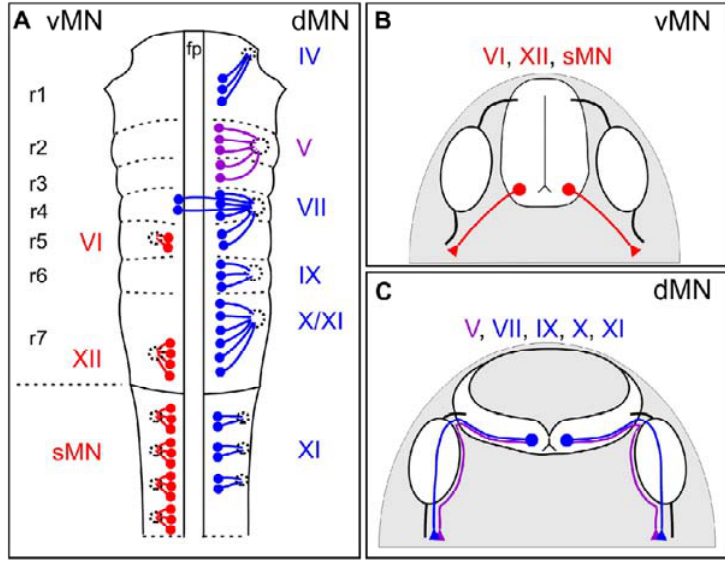
Figure 1. Motor neuron subtypes and the projections of their axons out of the CNS. ( A ) Schematic of motor neuron nuclei in the developing brainstem (rhombomere (r), r1 to r7) and spinal cord. vMNs are indicated in red on the left, whereas dMNs are indicated in blue on the right of the schematic. Trigeminal (V) motor nuclei are shown in purple. Each cranial motor nuclei is numbered in roman numerals, e.g., CN XI. Abbreviations: fp, floor plate; sMN, spinal motor neuron; ( B ) Axonal projections of vMNs in the hindbrain (VI, XII) and spinal cord (sMN) are shown in red; ( C ) Axonal projections of dMNs (VII, IX, X, XI) and trigeminal (V) dMNs are shown in blue and purple, respectively. Note that axons extending from trigeminal dMNs avoid sensory ganglia (white ovals), while axons of other dMN invade these ganglia [6].